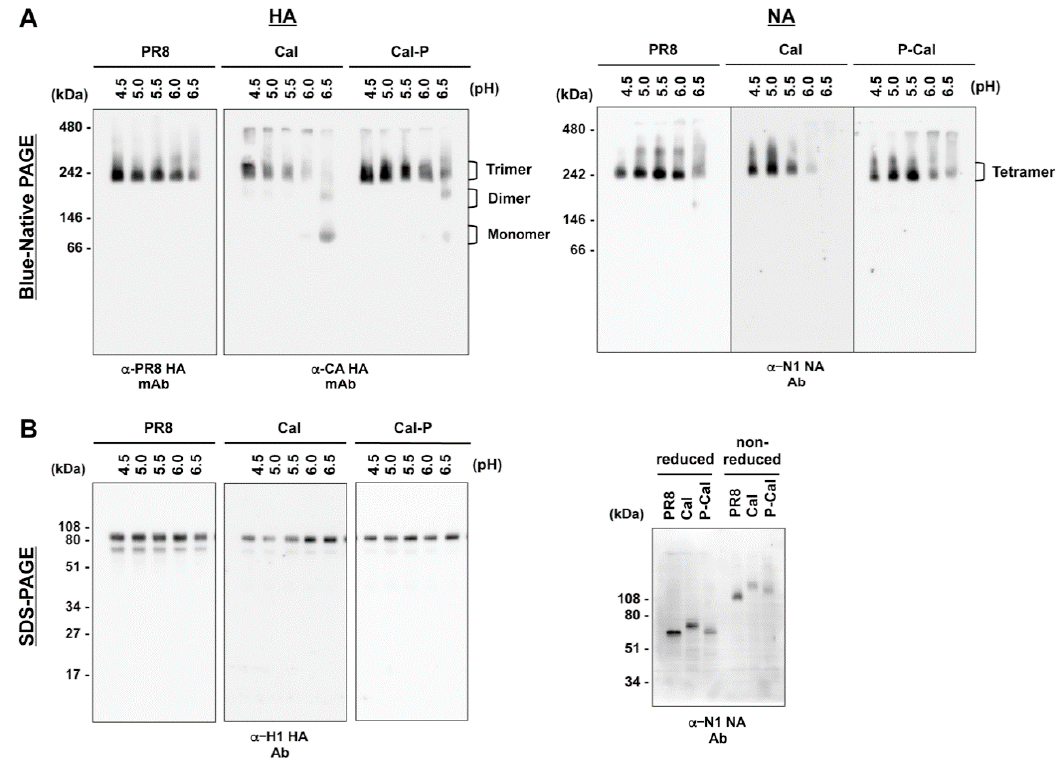
Figure 6. Stability of HA trimers and NA tetramers. 293T cells were transfected with HA and NA expression plasmids. The cells were incubated in buffers (pH, 4.5–6.5) and lysed with 1% Triton X-100. ( A ) After clarification, the supernatants were subjected to Blue-native (BN)-PAGE with 4–12% gradient polyacrylamide gels, followed by Western blotting with anti-PR8 HA or anti-Cal HA mAb ( left ) and anti-NA sheep Ab ( right ). ( B ) The cell lysates were subjected to SDS-PAGE, followed by Western blotting with anti-H1 HA rabbit Ab ( left ) and anti-NA sheep Ab ( right ). Representative blots are shown.